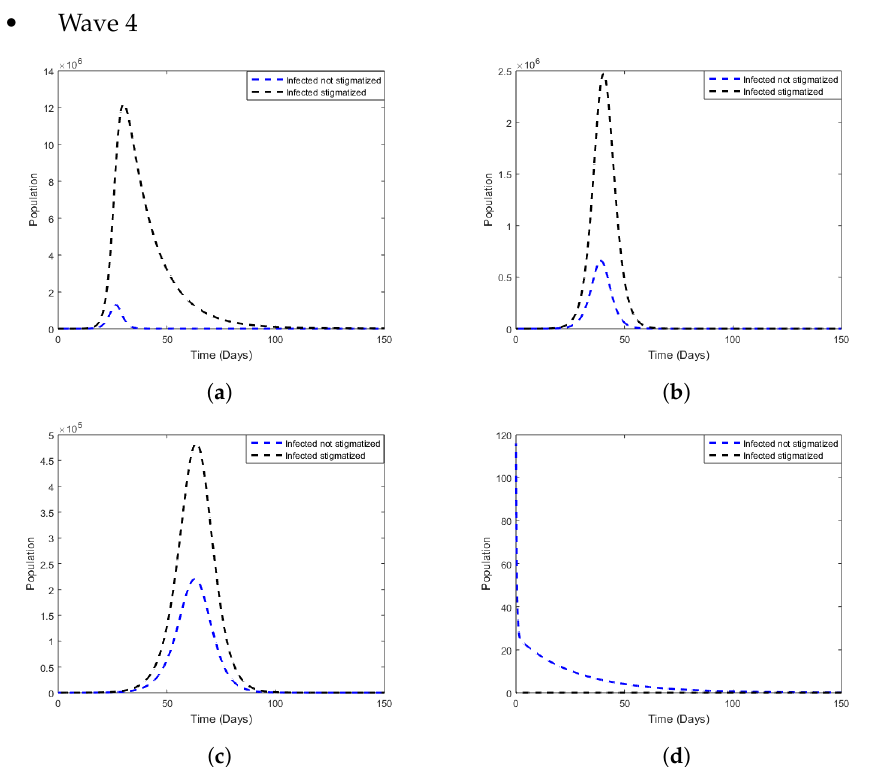
Figure 8. Comparison between non-stigmatised and stigmatised populations, varying γ for fixed values of p for the cases where there is stigma. ( a ) High stigma, γ = 0 and p = 0.49. ( b ) Moderate stigma, γ = 0.4 and p = 0.49. ( c ) Low stigma, γ = 0.8 and p = 0.49. ( d ) Stigma-free, γ = 0 and p =